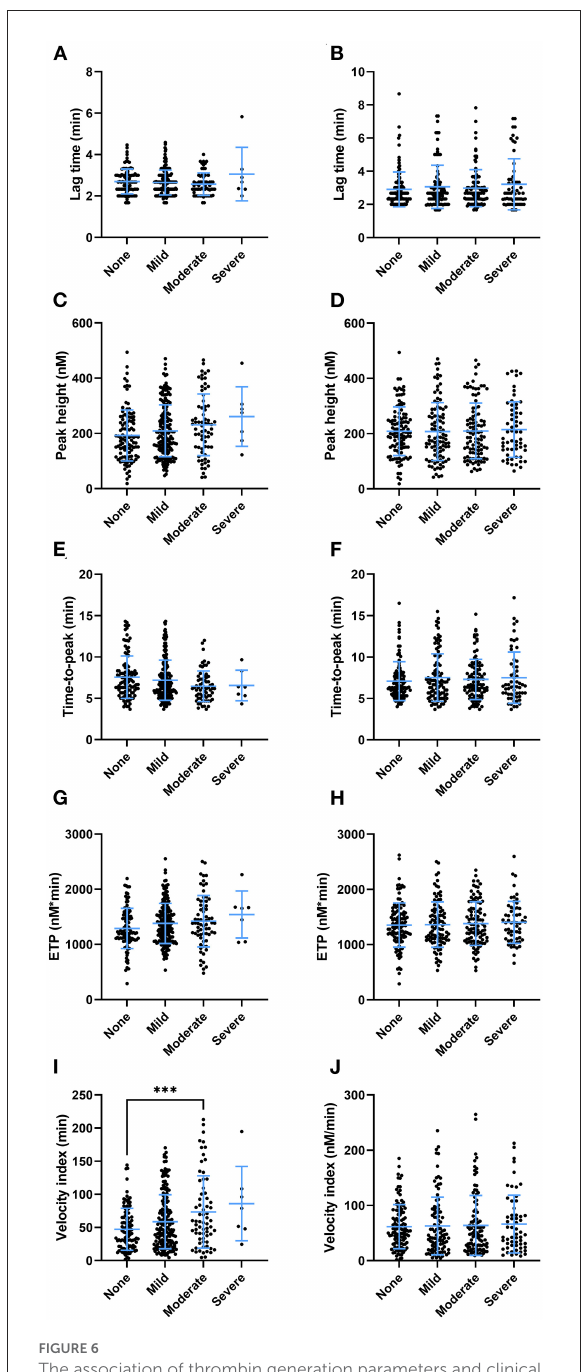
FIGURE6 The association of thrombin generation parameters and clinical symptoms after the second round of vaccination as reported by subjects vaccinated with ChAdOx1-S with and without prior COVID-19 infection. (A,B) The lag time did not differ significantly at the increasing levels of injection site symptoms (A) or systemic symptoms (B) . The peak height differed significantly between subjects with increasing injection site symptoms ( p < 0.038), although the study was underpowered to detect differences between specific groups in post hoc analysis (C) . Increasing systemic symptoms did not result in differences in peak height (D) . (E,F) The time-to-peak differed significantly (Continued)